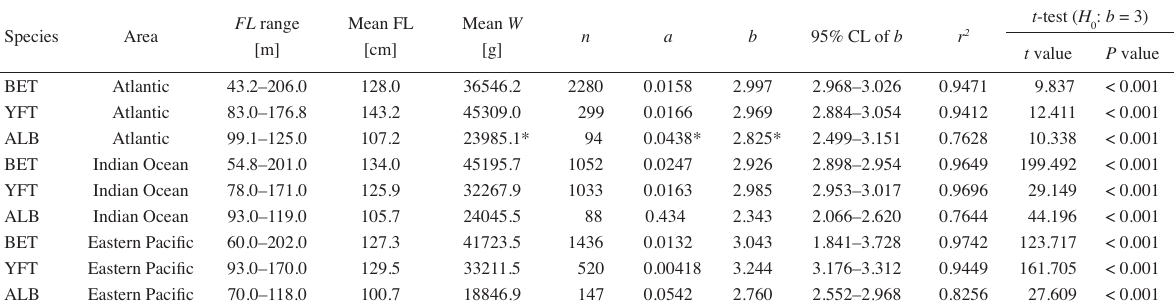
* Weight is whole weight [g]; BET = bigeye tuna; YFT = yellowfin tuna; ALB = albacore; n : sample size; FL: fork length [cm]; W : gilled-gutted weight [g]; CL = confidence limit; a = the parameter in the W – L relation; b = slope; r 2 = coefficient of